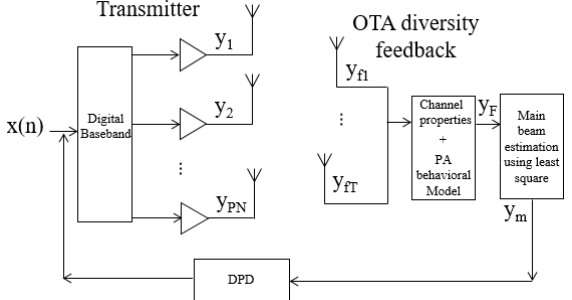
Figure 2. Block diagram representing the steps to apply the beam-oriented DPD using OTA diversity feedback method.